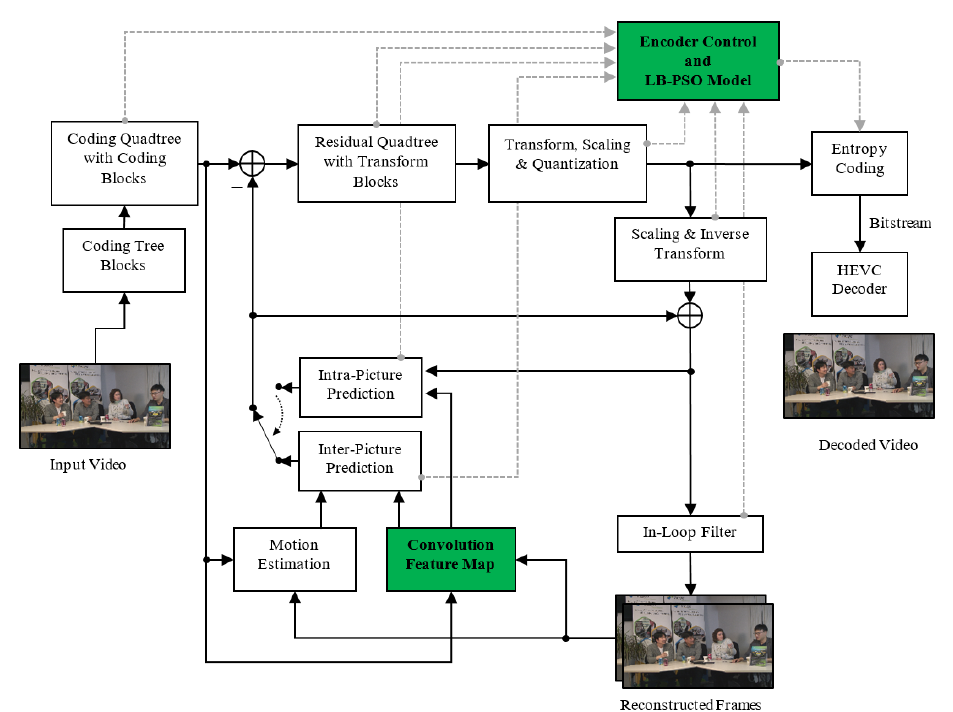
Figure 1. Learning-Based Rate Control Diagram for High Efficiency Video Coding.